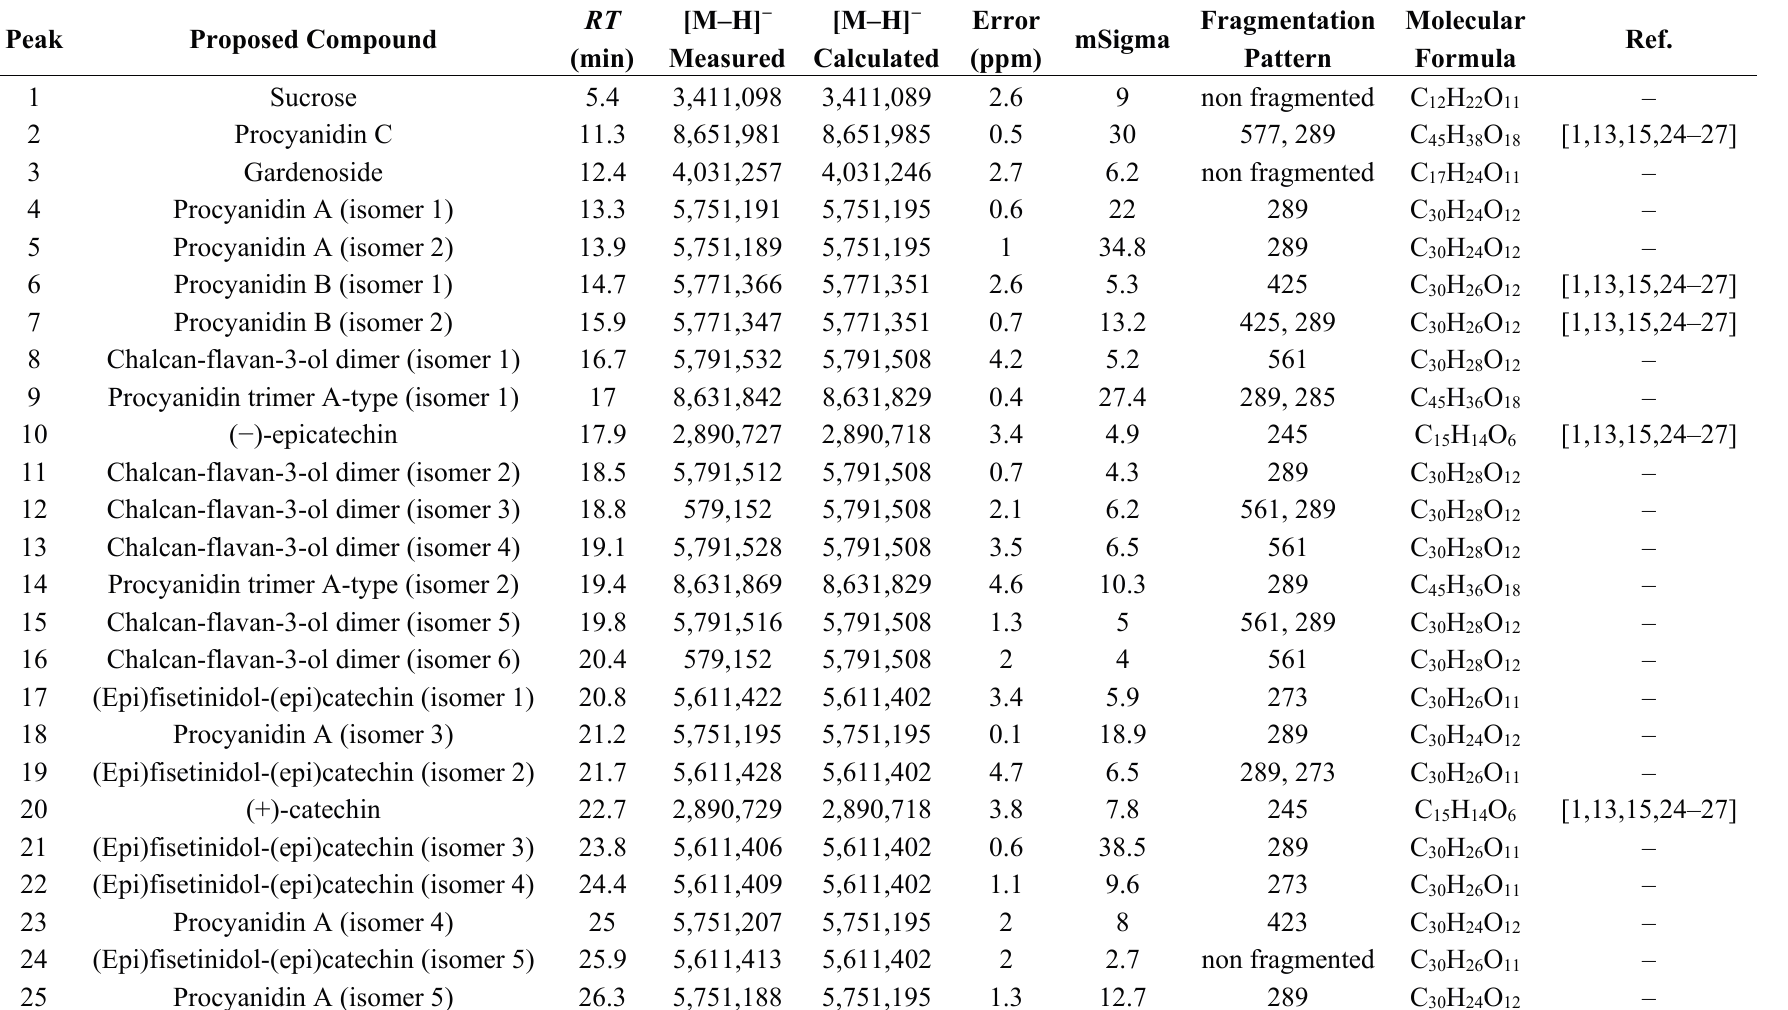
Table 1. Retention time and mass spectral data of the compounds characterized in pine bark extract by HPLC–ESI-QTOF-MS and MS/MS in negative